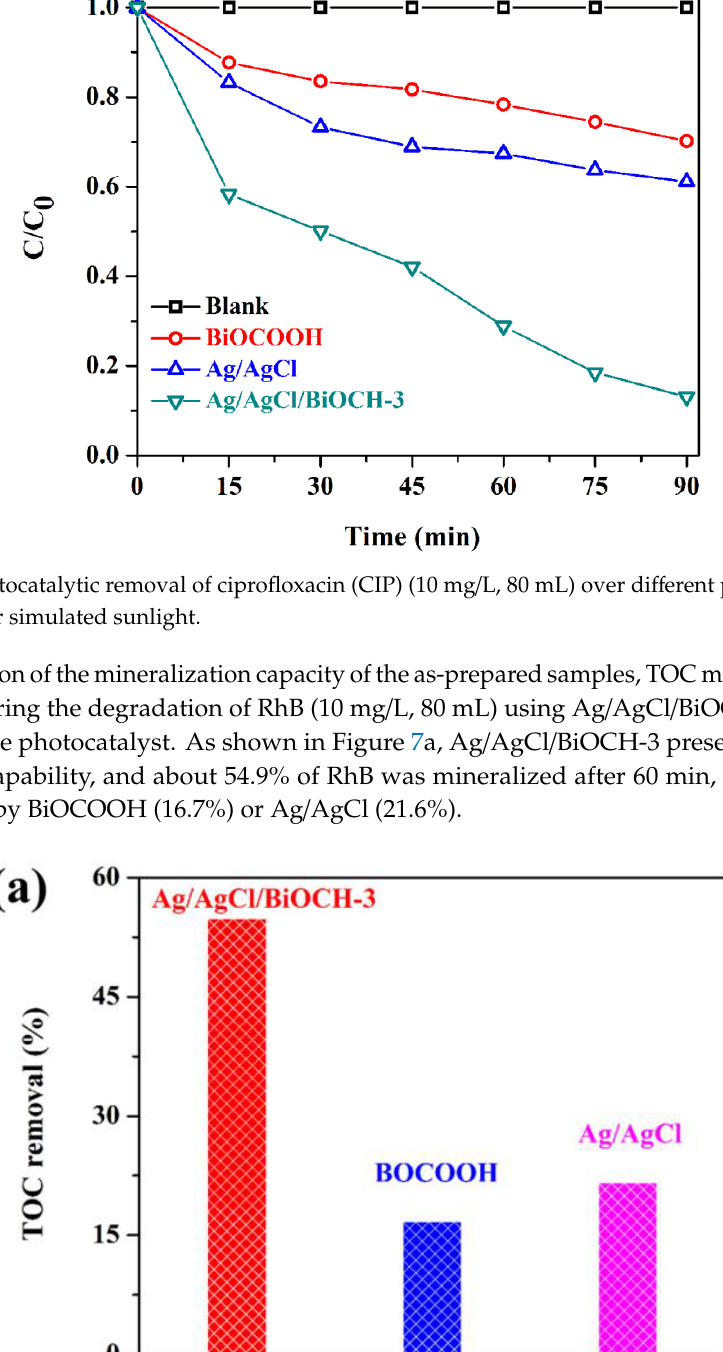
Figure 7. ( a ) TOC removal of RhB (10 mg/L, 80 mL) over Ag/AgCl/BiOCH-3 (30 mg), BiOCOOH (30 mg), or Ag/AgCl (30 mg) after 60 min of illumination; ( b ) recycling tests of Ag/AgCl/BiOCH-3 (30 mg) for RhB (10 mg/L, 80 mL) removal. Recyclability of a photocatalyst is another important parameter for practical utilization in industry [29,30]. Hence, recycling experiments for RhB degradation by Ag/AgCl/BiOCH-3 were executed. In each run, 30 min of dark adsorption and 30 min of visible-light irradiation were involved. As displayed in Figure 7b, Ag/AgCl/BiOCH-3 showed satisfactory photocatalytic behavior without apparent loss of activity even after six successive runs. Moreover, the XRD technique was employed to characterize the recycled Ag/AgCl/BiOCH-3 after six runs. As observed in Figure S1, no additional peaks were detected compared to those in the XRD pattern of the fresh Ag/AgCl/BiOCH-3, proving the stable crystalline structure. In other words, the Ag/AgCl/BiOCH-3 ternary heterojunction is a kind of stable photocatalyst that can be utilized for at least six runs with steady photocatalytic activity. 3.4. Reaction Mechanism